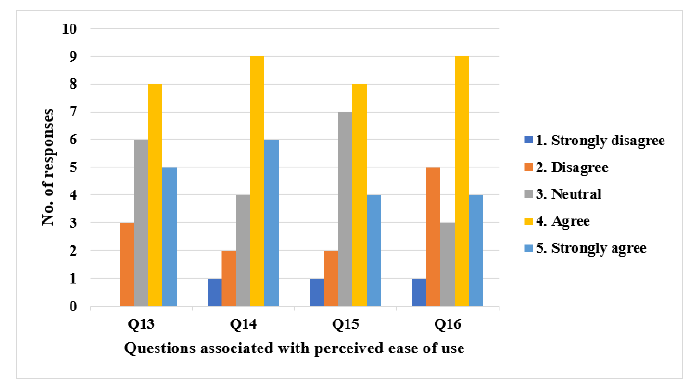
Figure 6. Number of responses for items related to PEU.